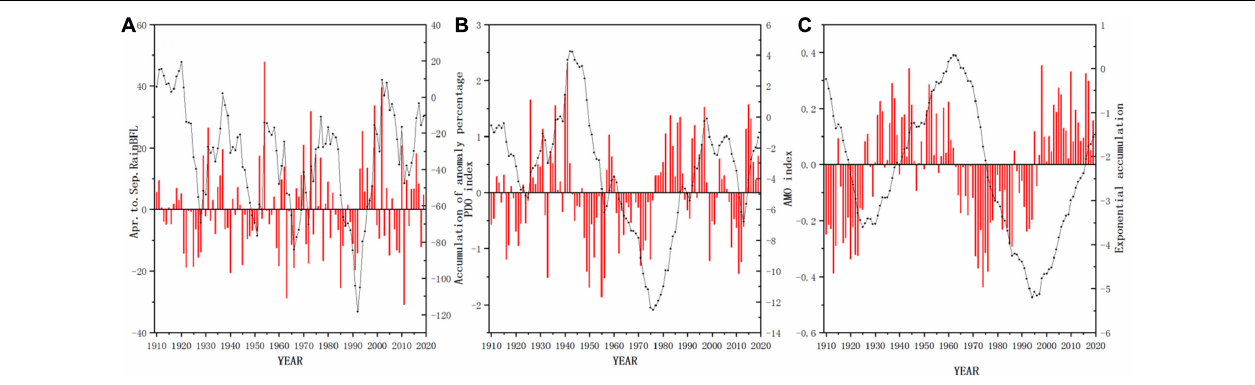
FIGURE 1 | Time series of (A) the precipitation anomaly percentage, (B) PDO index, and (C) AMO index in Hunan flood seasons during 1910–2019 (the red line is the exponential sequence and the black line is the anomaly accumulation value).